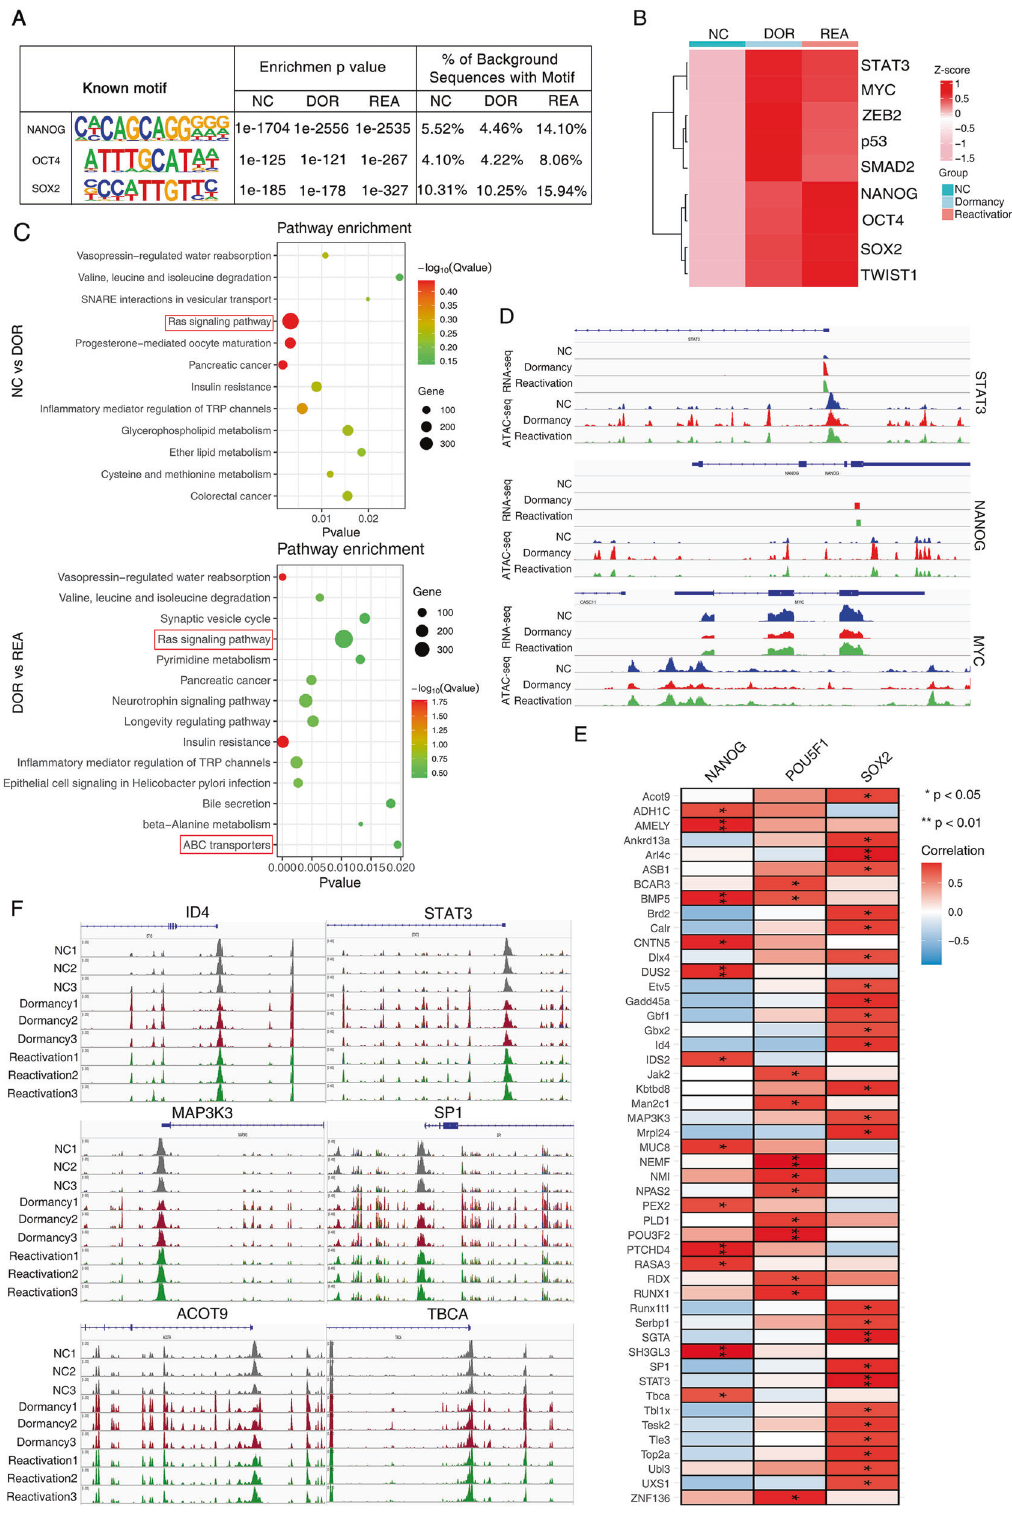
involvement of ephrins. The overexpression of FN Δ , CRD Δ , LBD Δ caused upregulations of p-EphB1 independent of EfnB2 due to the reduction of inhibitory cis signaling (Fig. 7B, line 2,3,4,5). Y594 Δ transfection did not show activation of Eph trans signaling (Fig. 7B, line6). Compared to the transfection of WT EphB1,